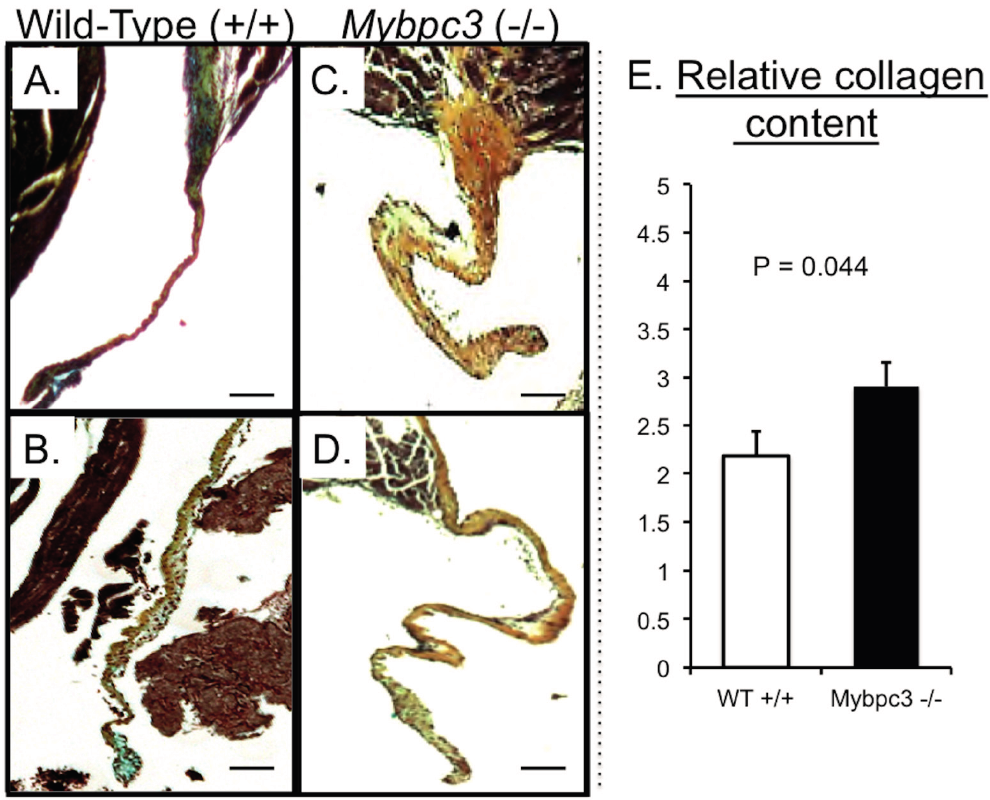
Figure 4. Mybpc3 ( − / − ) MVs have more collagen. MVs were stained with modified Movat’s ( A – D ). The Mybpc3 ( − / − ) MV leaflets ( C , D ) show more collagen (yellow − brown in C and D ) than the Wild-Type (+/+) MV leaflets ( A , B ). All size bars correspond to 100 μ M. Relative quantification of collagen ( E ) on Movat’s staining was performed by